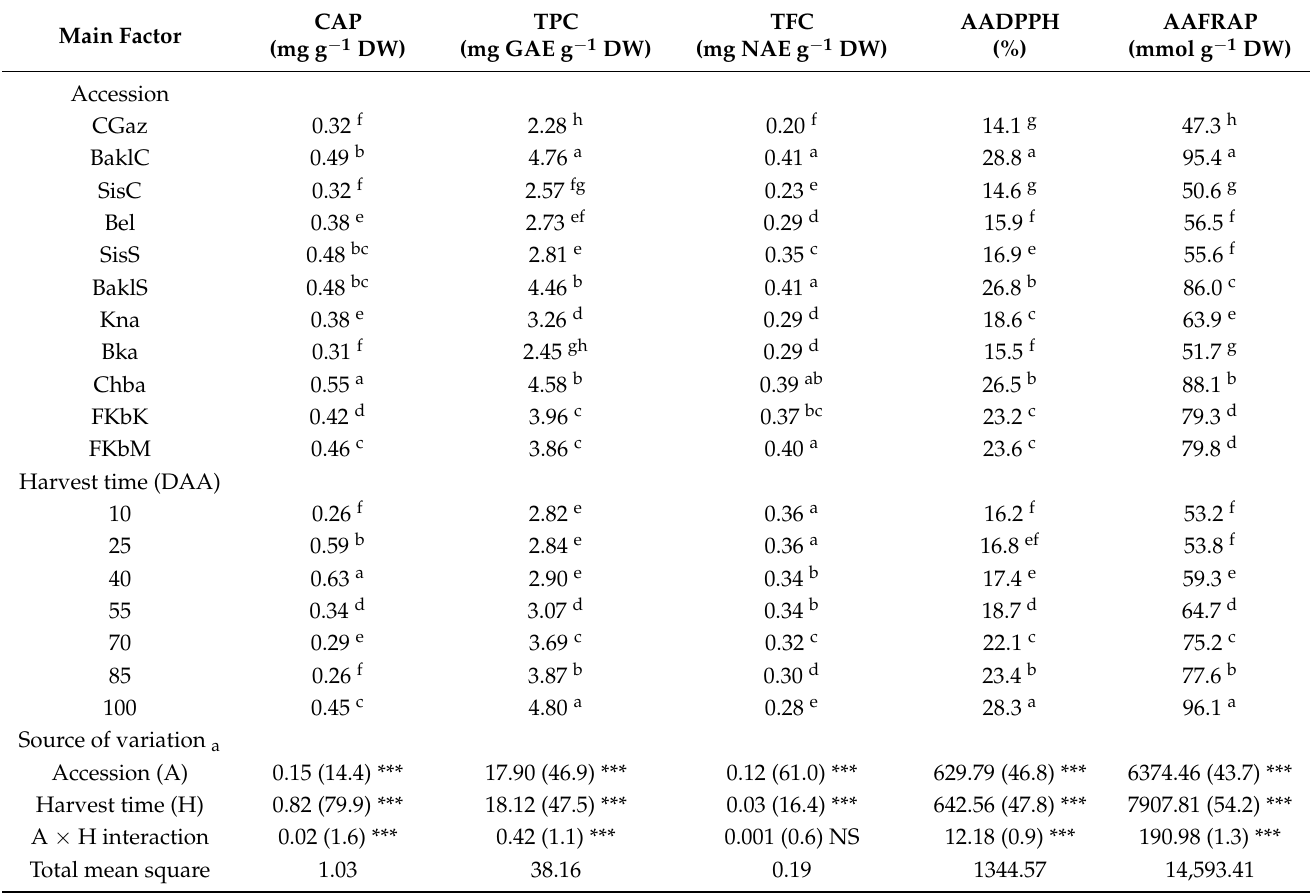
Table 5. Two-way ANOVA results for the analyzed biochemical traits of Tunisian chili